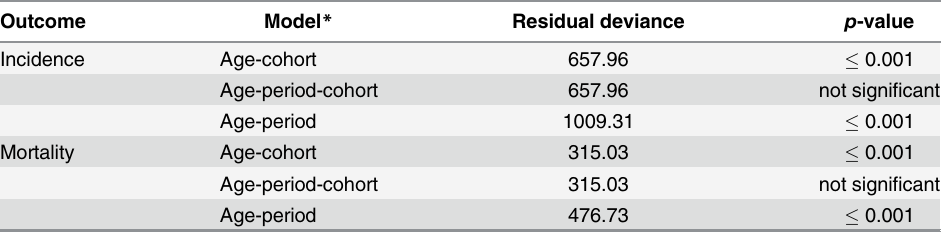
Table 4. Age-Period-Cohort Modeling for Incidence and Mortality of Breast Cancer in Women using apc of R package — Sensitivity Analysis. Outcome Model